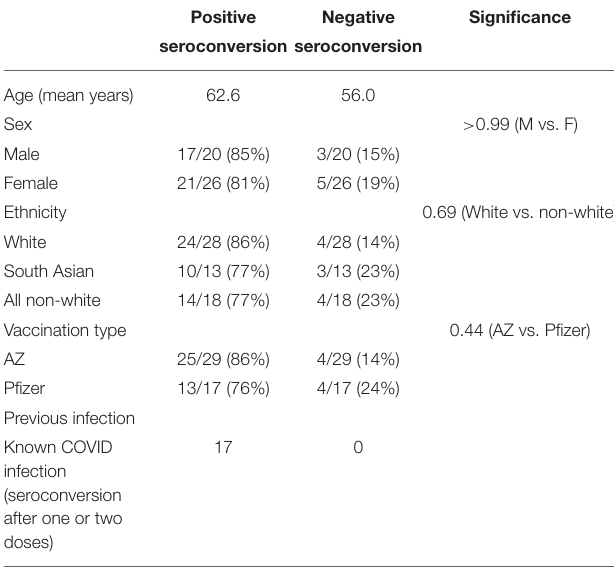
TABLE 4 | Analysis of seroconversion by immunosuppressive regimen.